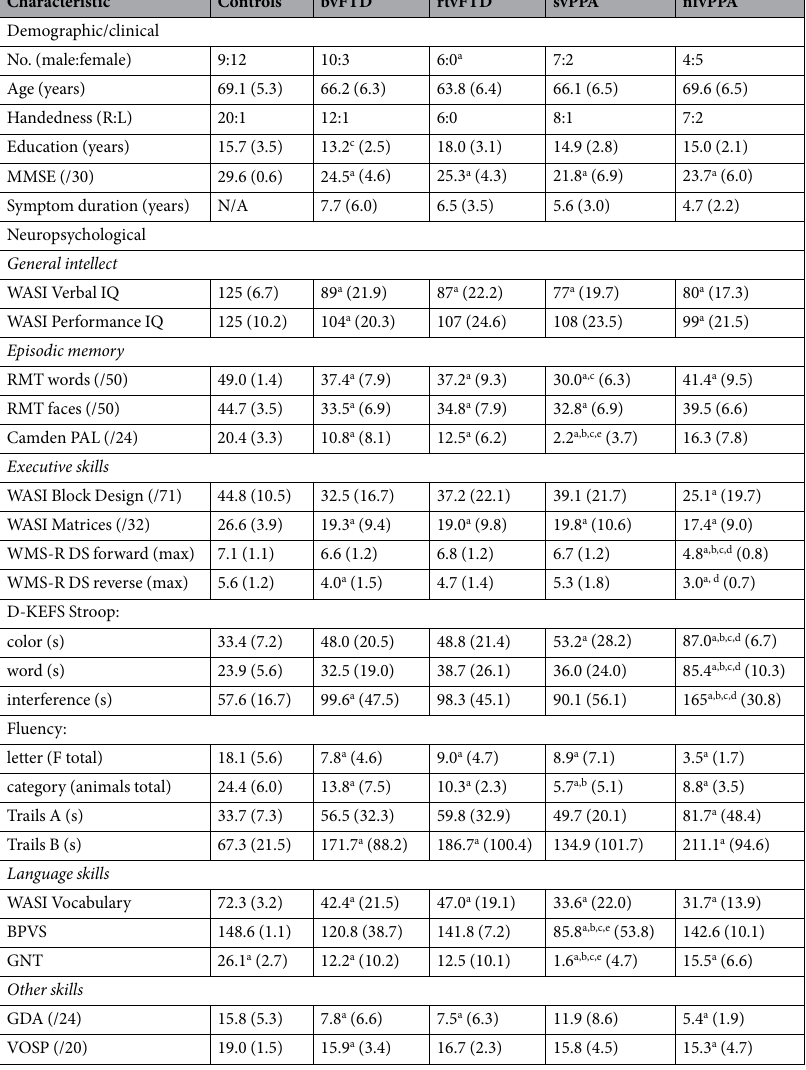
Table 1. Demographic, clinical and neuropsychological characteristics of participant groups. Mean (standard deviation) scores are shown unless otherwise indicated; maximum scores are shown after tests (in parentheses). a significantly different from healthy controls, b significantly different from bvFTD, c significantly different from rtvFTD, d significantly different from svPPA, e significantly different from nfvPPA (all p < 0.05). BPVS, British Picture Vocabulary Scale (Dunn LM et al ., 1982); bvFTD, patient group with behavioural variant frontotemporal dementia (excluding right temporal cases); Category fluency totals for animal category and letter fluency for the letter F in one minute (Gladsjo et al ., 1999); Controls, healthy control group; D-KEFS, Delis Kaplan Executive System (Delis et al ., 2001); DS, digit span; GDA, Graded Difficulty Arithmetic (Jackson M and Warrington, 1986); GNT, Graded Naming Test (McKenna and Warrington, 1983); MMSE, Mini-Mental State Examination score (Folstein et al ., 1975); N/A, not assessed; NART, National Adult Reading Test (Nelson, 1982); nfvPPA, patient group with nonfluent variant primary progressive aphasia; PAL, Paired Associate Learning test (Warrington, 1996); RMT, Recognition Memory Test (Warrington, 1984); rtvFTD, patient subgroup with right temporal variant frontotemporal dementia; svPPA, patient group with semantic variant primary progressive aphasia; Synonyms, Single Word Comprehension: A Concrete and Abstract Word Synonyms Test (Warrington et al ., 1998); Trails-making task based on maximum time achievable 2.5 minutes on task A, 5 minutes on task B (Lezak et al ., 2004); VOSP, Visual Object and Spatial Perception Battery – Object Decision test (Warrington and James, 1991); WAIS-R, Wechsler Adult Intelligence Scale‐-Revised (Wechsler, 1981); WASI, Wechsler Abbreviated Scale of Intelligence (Wechsler, 1997); WMS, Wechsler Memory Scale (Wechsler,